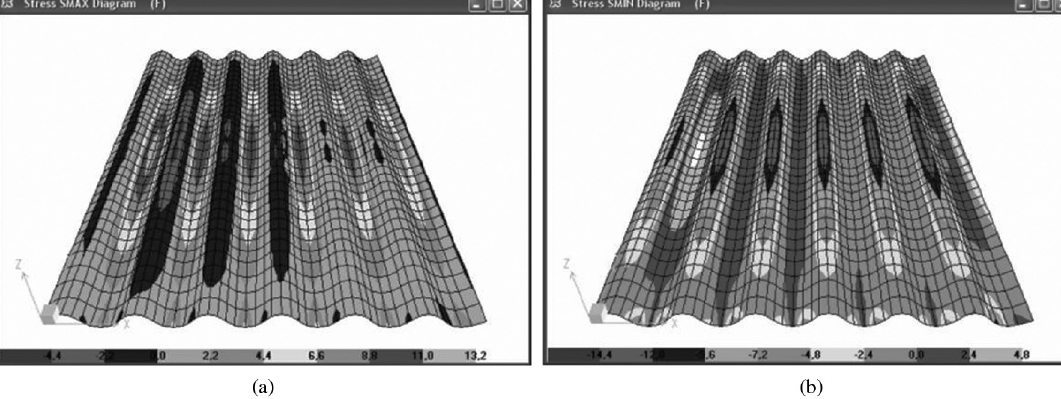
) in the lower surface of the low wave, (b) max